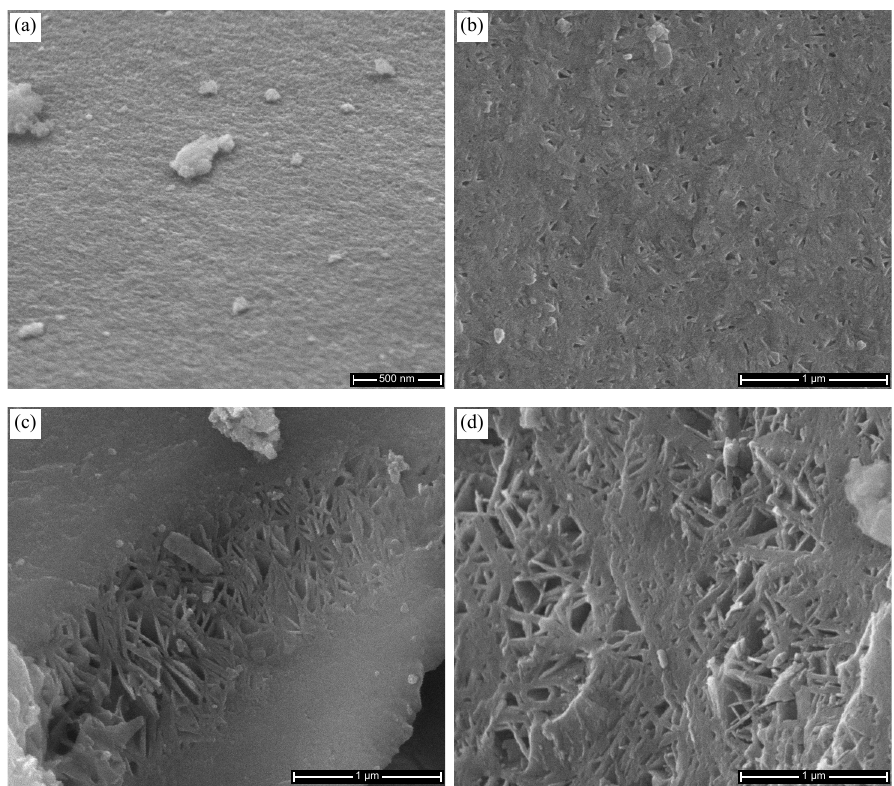
Figure 3. SEM images showing differing appearances of selected zones of opal-CT: ( a ) G25374 (labelled as from Somalia), ( b ) G7975 fire opal from Mexico, ( c ) G13740 opalized wood from Monto, Queensland, Australia, and ( d ) G9942 from Angaston, South Australia, Australia.